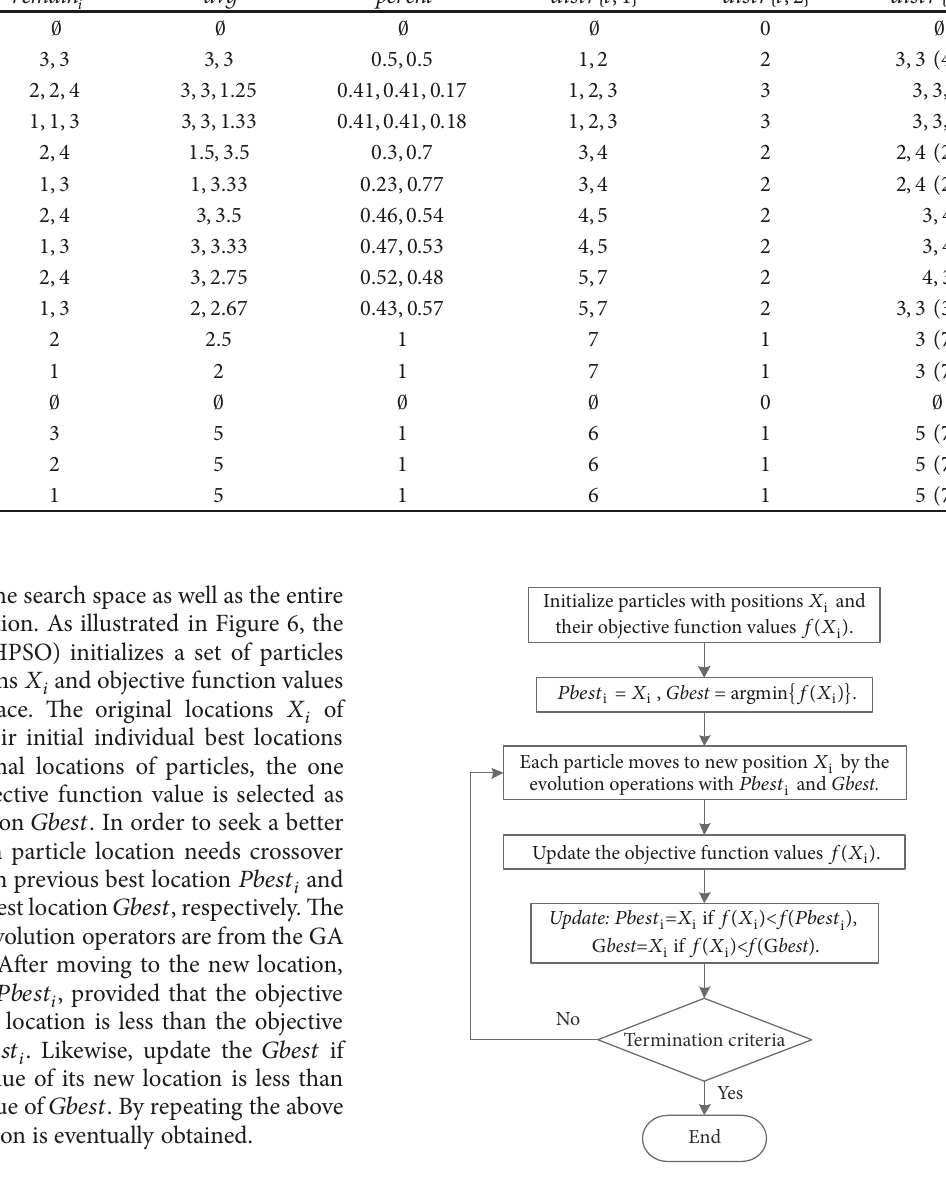
Figure 6: Flowchart of